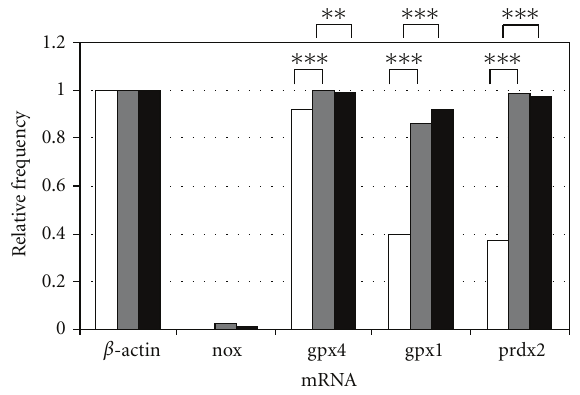
Figure 4: Quantitative analysis of mRNA expression of nox , gpx4 , gpx1 and prdx2 of single murine blastocyst either cultured in vivo (white) or in vitro in COOK’s Cleavage medium (grey) or in Vitrolife’s G-1 PLUS medium (black) compared to β -actin as housekeeping gene with ∗ P < 0 . 05; ∗∗ P < 0 . 02; ∗∗∗ P < 0 .